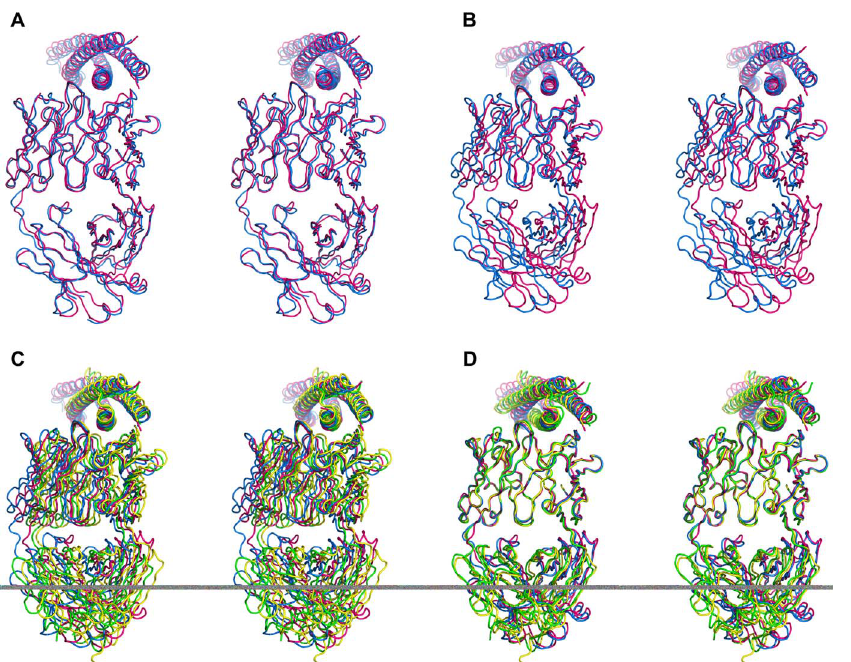
Figure 8. Different superpositions of the complexes of two Fabs with 3-H and 5-Helix. (A) Overall superposition of the complexes was generated by superimposing the C a coordinates of 3 Fabs and 3-H with the program Align. For clarity, only a single Fab of each complex is shown (Fab 8066/3-Hcomplex in red, Fab 8062/3-H complex in blue). (B) Superposition as in A, but based on the C a atoms of 3-H. (C) A ribbon diagram of (Fab 8066) 3 /3-H complex (shown in red), (Fab 8062) 3 /3-H complex (shown in blue), Fab 8066/5-Helix complex (shown in green) and Fab 8062/5-Helix complex (shown in yellow) superimposed based on C a coordinates of 3 N-HR helices. (D) Superposition of single Fabs in the complexes with 3-H and 5-Helix based on C a atoms of the b -sheet framework of variable domains. (Fab 8066) 3 /3-H complex is red, (Fab 8062) 3 /3-Hcomplex is blue, Fab 8066/ 5-Helix complex is green, and Fab 8062/5-Helix complex is yellow. Only the N-HR helices of 5-Helix are shown. doi:10.1371/journal.pone.0078187.g008 a relatively short interaction interface with CCIZN36 towards the addition, in the complexes with 5-Helix two residues of CDR L3, C-terminal end of the epitope, between Trp571 and Ala578 of Ser93 and Met94, interact with residues of the C-HR helix. helix A, with a similar number of contacts in the two complexes. In